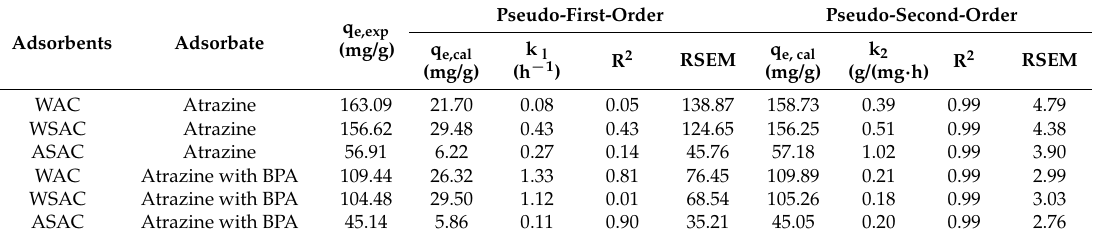
Figure 2. Influence of BPA on adsorption kinetics of atrazine onto WAC ( a ); WSAC ( b ); ASAC ( c ). Table 5. Influence of BPA on adsorption kinetic parameters of atrazine onto ACs.